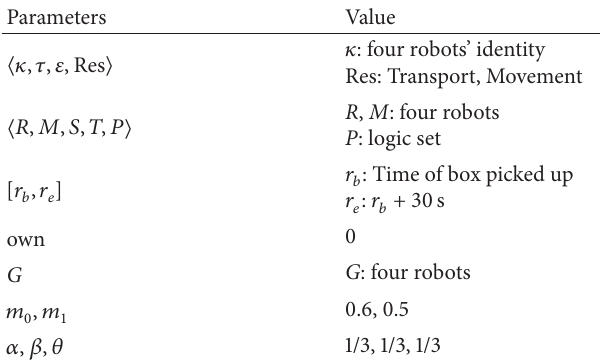
Table 2: The experimental